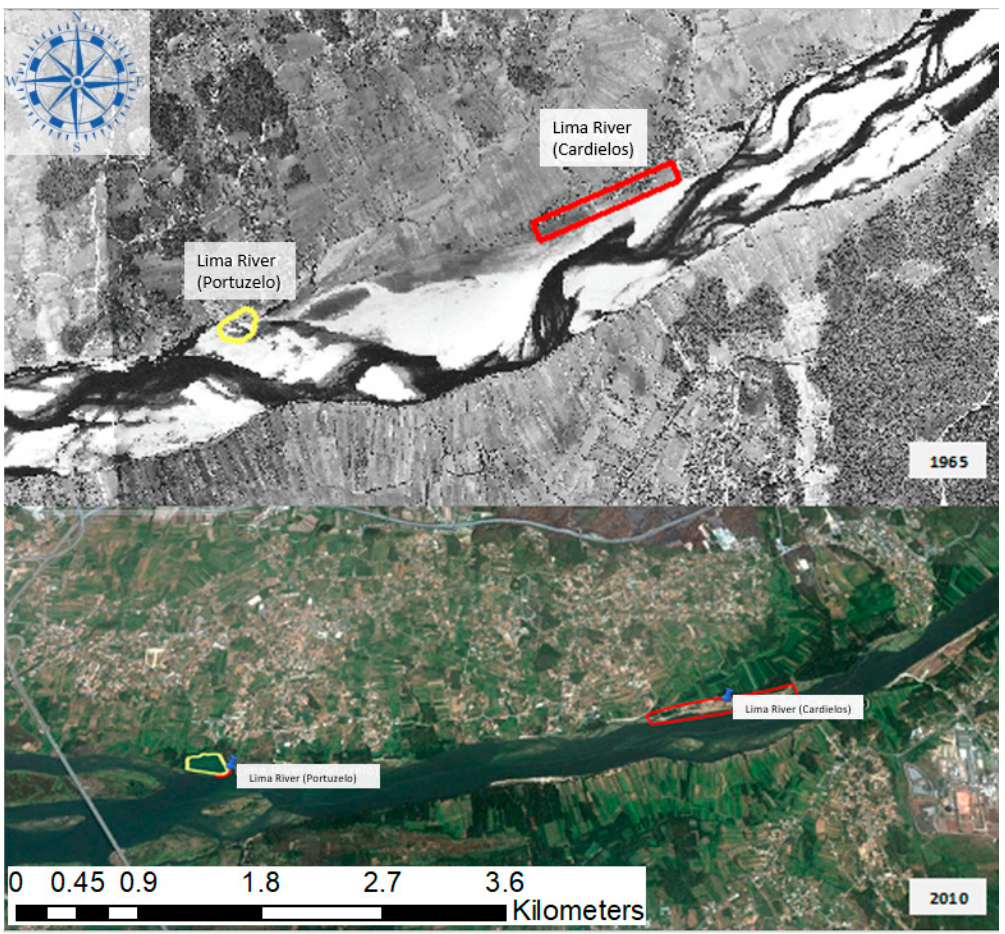
Figure 1. Aerial photographs of a part of the R. Lima estuary with the localization of the two considered priority segments for intervention: the comparison of the year 1965 with meander characteristics and the year 2010 without sediment in the river is shown. The yellow line intervention areas represent Portuzelo and red represents Cardielos.